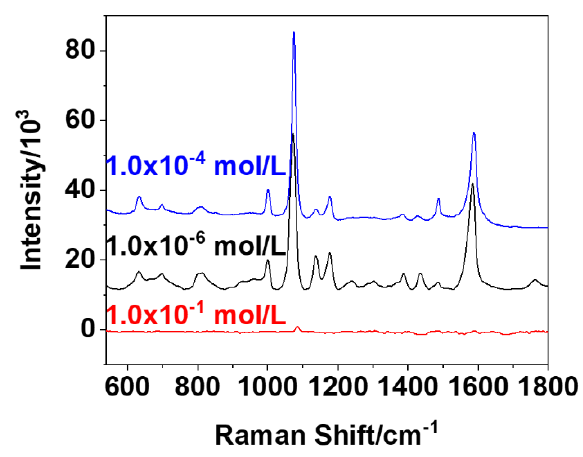
Figure 4. Raman spectra acquired at 0.1 M pATP on a bare silicon surface ( bottom ), at 1.0 × 10 − 6 M pATP on a 266-nm SiO 2 @nAg-assembled monolayer PC substrate ( middle ), and at 1.0 × 10 − 4 M pATP on a silicon slide deposited with isolated 266-nm SiO 2 @nAg particles ( upper ).